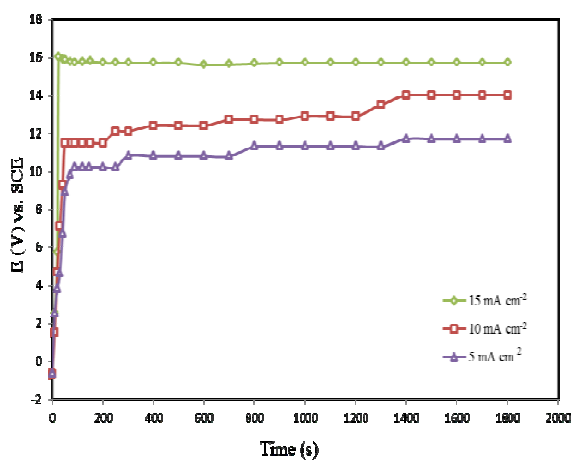
Fig. 1. E-t curves under galvanostatic polymerization conditions in 0.5 M oxalic acid solution containing 0.1 M aniline and 1 wt% dispersed TiO nanoparticles for AA3004 electrode at various current densities.